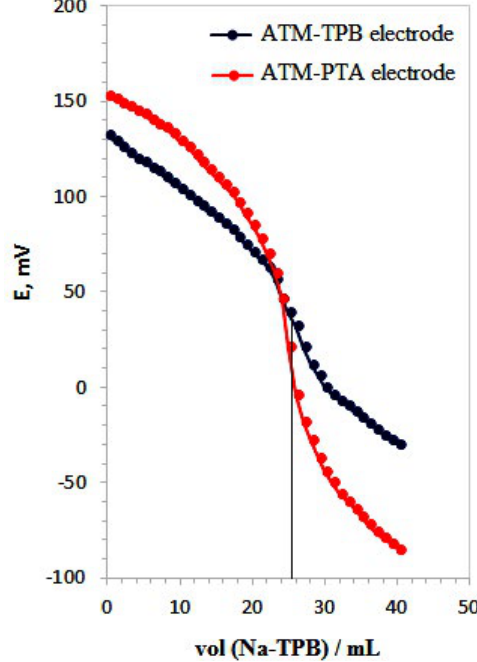
Fig. 6. Potentiometric titration curve of 25.0 mL 1.0 × 10 –3 M atom- oxetine hydrochloride solution with 1.0 × 10 –3 M Na-TPB standard solution using ATM-TPB and ATM-PTA